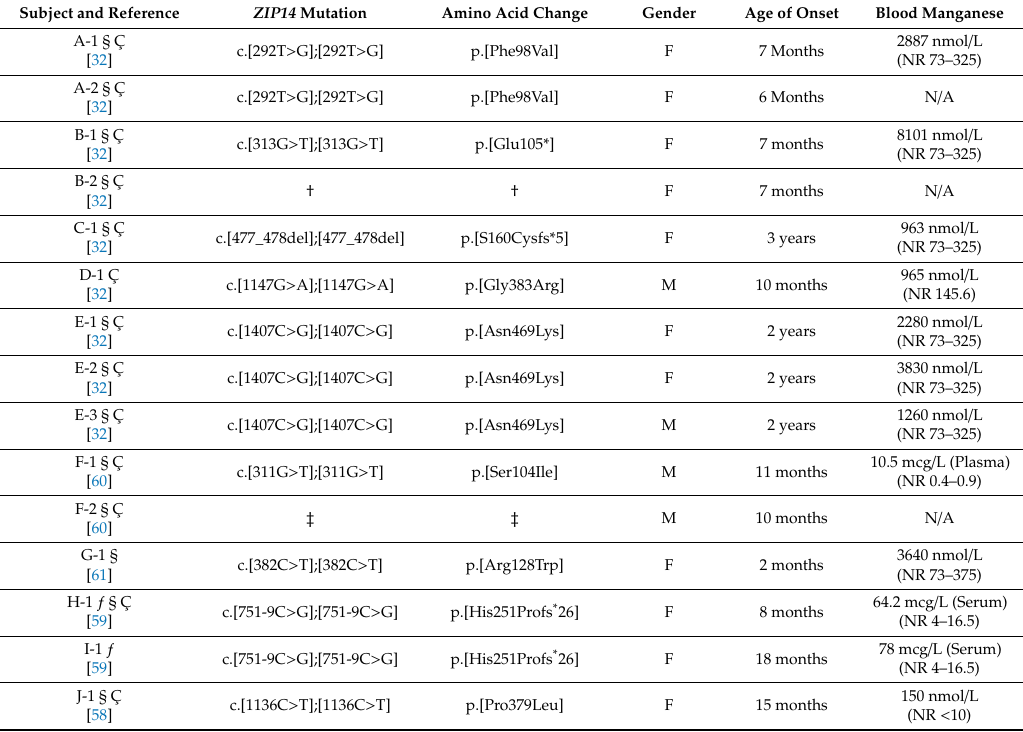
Table 2. Identified human cases of ZIP14